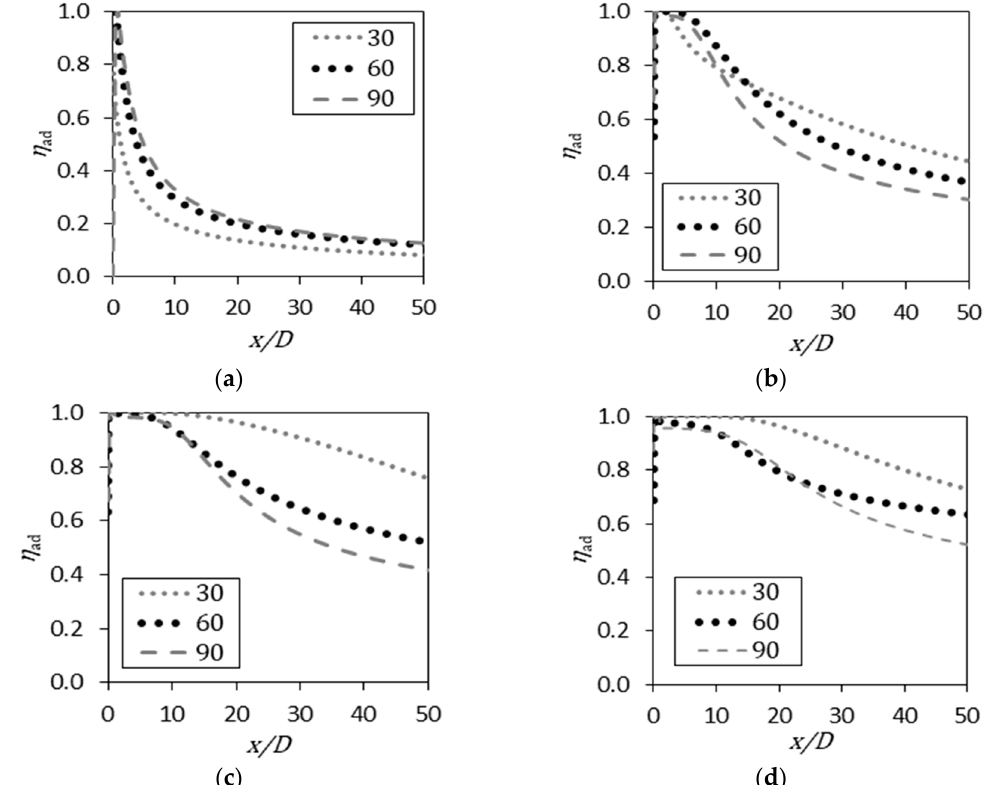
Figure 7. AFCE for 𝐷𝑅 = 1.2 at various injection angles and blowing ratio of (a) 𝑀 = 0.1 , (b) 𝑀 = Figure 7. AFCE for DR = 1.2 at various injection angles and blowing ratio of (a) M = 0.1, (b) M = 0.5, 0.5 , (c) 𝑀 = 1.0 and (d) 𝑀 = 2.0 . (c) M = 1.0 and (d) M =